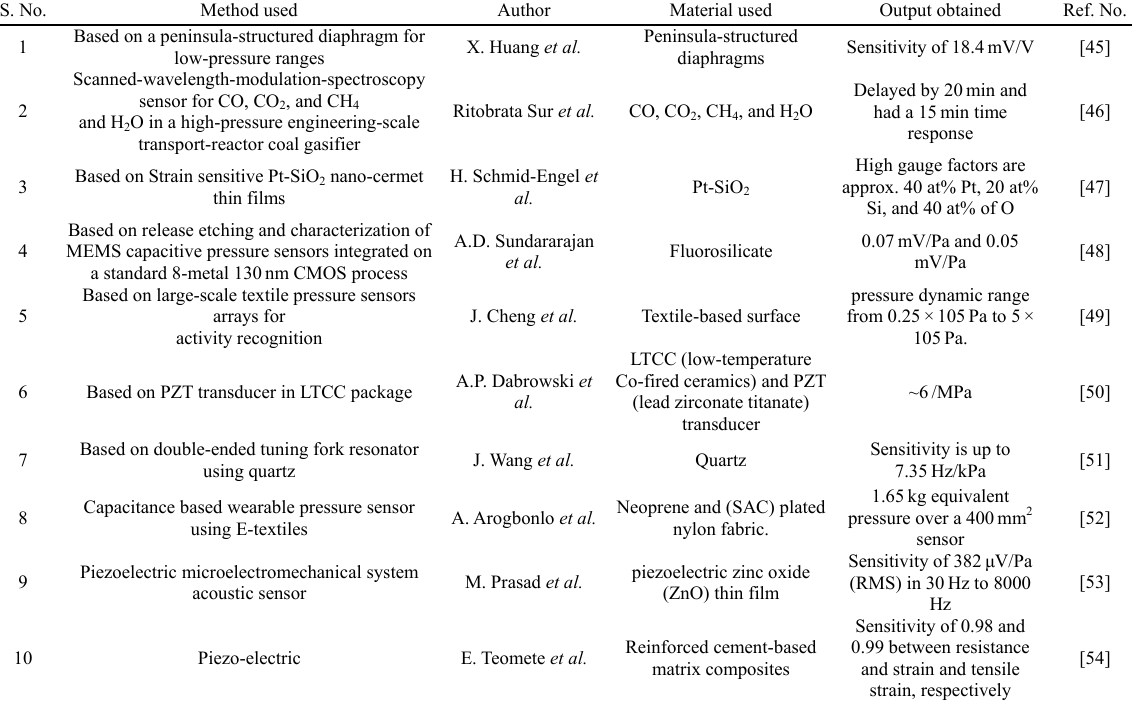
Table 2 Literature survey of the recent pressure sensors including their construction and working principle. S.